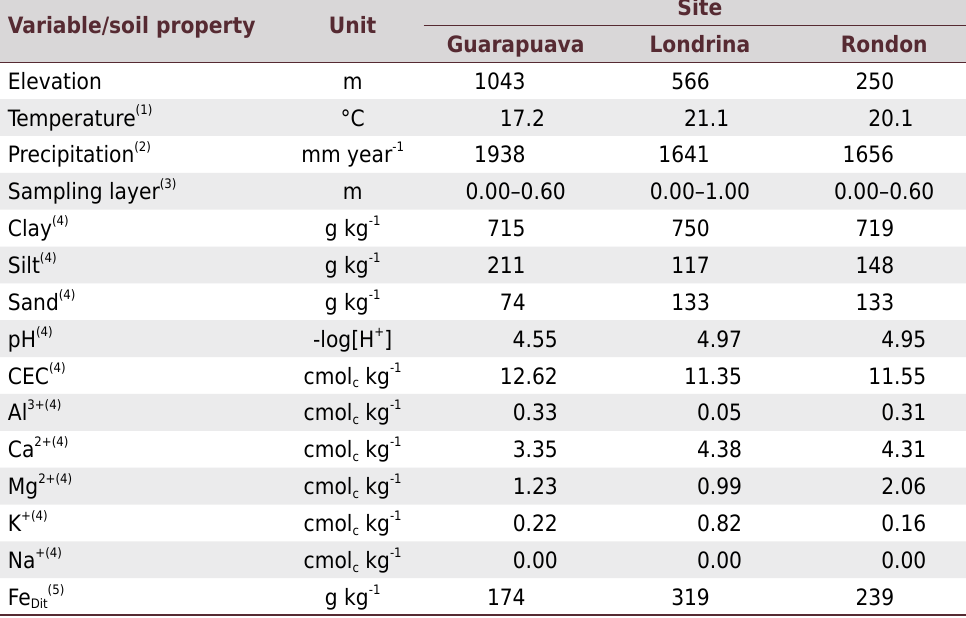
Table 1. Selected sites and soil properties Variable/soil